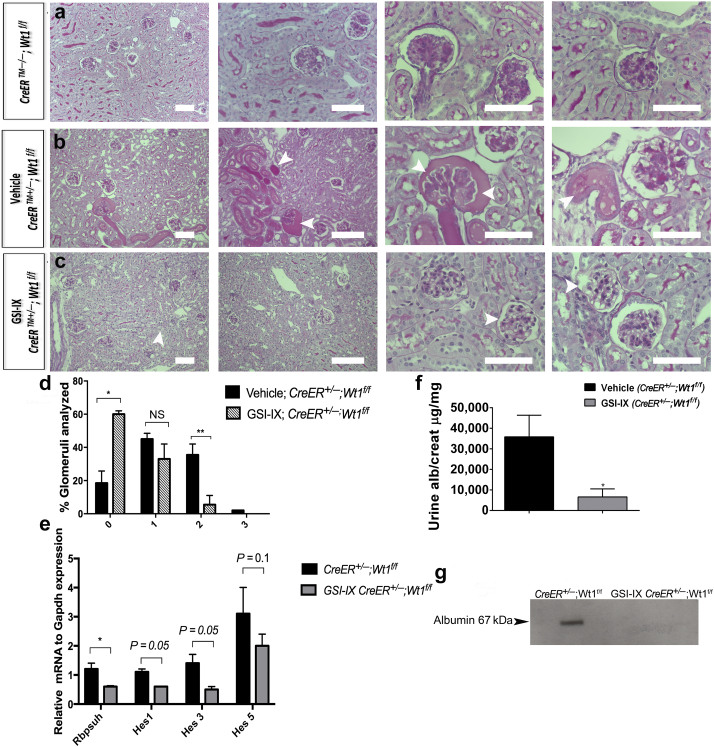
Gamma secretase inhibition of Notch ameliorates early Wilms’ tumor 1 (Wt1) glomerulopathy. (a–c) Shown are representative micrographs of periodic acid–Schiff–stained sections of glomeruli of CAGG-CreERTM−/−;Wt1f/f (a), vehicle (dimethylsulfoxide)-treated CAGG-CreERTM+/–;Wt1f/f (b), and gamma secretase inhibitor (GSI-IX)-treated CAGG-CreERTM+/−;Wt1f/f transgenic mice (c) isolated late on day 5 postinduction. Bars = 50 μm. (b) Vehicle-treated mice exhibit glomerulosclerosis with hyaline material in the tubules that was not seen in control mice (a). Glomeruli of GSI-IX–treated mutants (c) do not show the same extent of glomerulosclerosis as vehicle-treated mutants. (d) Quantitative graphs of a proportion of glomeruli per genotype revealing the extent of intraglomerulosclerosis (score 0: <25% glomerulus sclerosed; score 1: 25%–50% sclerosis; score 2: 50%–75% sclerosis; score 3: >75% sclerosis). Bars represent the mean percentage of each score per genotype. Error bars represent the SEMs. At day 5 postinduction, a higher proportion of GSI-IX–treated CAGG-CreER+/−;Wt1f/f transgenic mice (n = 52 glomeruli, n = 5 mice) exhibited normal glomerular morphology compared with vehicle-treated CAGG-CreER+/−;Wt1f/f (mutants) (n = 52 glomeruli, n = 4 mice): vehicle-treated CAGG-CreER+/−;Wt1f/f versus GSI-IX–treated CAGG-CreER+/−;Wt1f/f mutant transgenic mice: score 0: 18 ± 0.9% versus 59 ± 1.0%, *P < 0.02, Student t-test; score 2: 39 ± 5% versus 8 ± 3%, **P < 0.008, Student t-test. (e) Quantitative graph showing reduced mean relative Rbpsuh, Hes1, Hes3, and Hes5 mRNA expression in podocytes from GSI-IX–treated and untreated mutant mice: CAGG-CreER+/−;Wt1f/f versus GSI-IX–treated CAGG-CreER+/−;Wt1f/f mice: Rbpsuh: 1.2 ± 0.2 versus 0.6 ± 0.03, *P = 0.01; Hes1: 1.1 ± 0.1 versus 0.6 ± 0.01, P = 0.05; Hes3: 1.4 ± 0.3 versus 0.5 ± 0.1, P = 0.05; Hes5: 3.1 ± 0.9 versus 2.0 ± 0.4, P = 0.1. Bars represent means and error bars represent SEMs. (f) Quantitative graph showing median urine albumin-creatinine ratio in vehicle-treated versus GSI-IX–treated mutant mice. Bars represent the median of each group. Error bars represent the interquartile ranges (IQRs): CAGG-CreER+/−;Wt1f/f versus GSI-IX–treated CAGG-CreER+/−;Wt1f/f mice: 35,836 (IQR: 21,304, 46,371) versus 6657 (IQR: 1337, 10,565), *P = 0.02, Mann-Whitney U test. (g) Western blot analysis demonstrates albumin in urine samples of vehicle-treated versus GSI-IX–treated mutant mice (molecular weight of albumin: 66.5 kDa). To optimize viewing of this image, please see the online version of this article at www.kidney-international.org.